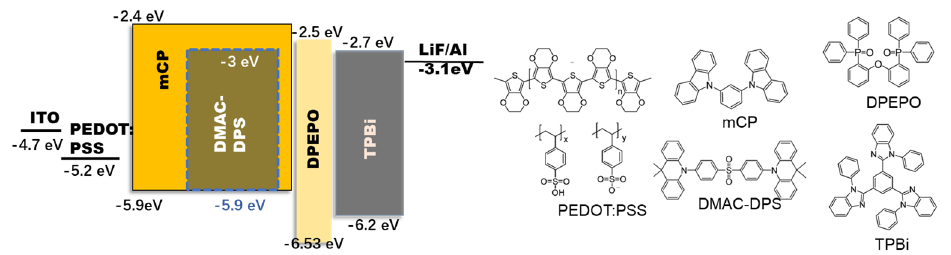
Figure 1. Schematic diagram of energy level structure of OLEDs and the chemical structure of ma- terials.